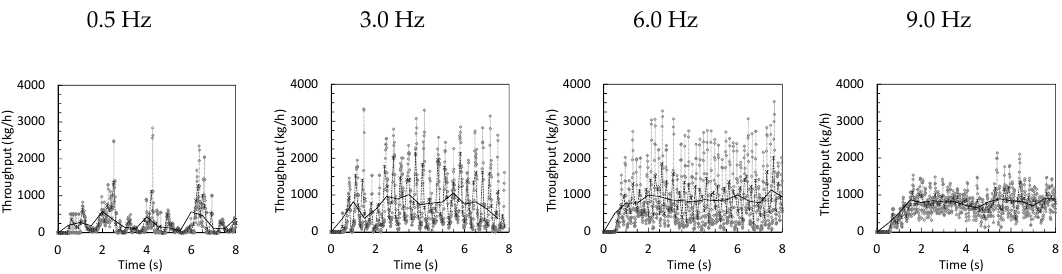
Figure 16. DEM jaw crusher simulation results showing raw throughput data for different stroke frequencies. Crusher fed with a range of sizes (63–13 mm) and CSS constant at 7.5 mm. Results show the dynamics of the jaw crusher DEM model and the throughput response to the disturbances given by the stroke frequency of the swing plate. As observed in Figure 16, the DEM simulations respond to the changes in frequency. Additionally, more stable behavior with less scattered results from operation at the frequency of 9.0 Hz. Figure 17 presents results on the sensitivity analyzes of the jaw crusher DEM model with the embedded Particle Replacement Model. It shows the variation of crusher capacity, compressive force, power and reduction ratio as a function of stroke frequency and closed side setting.